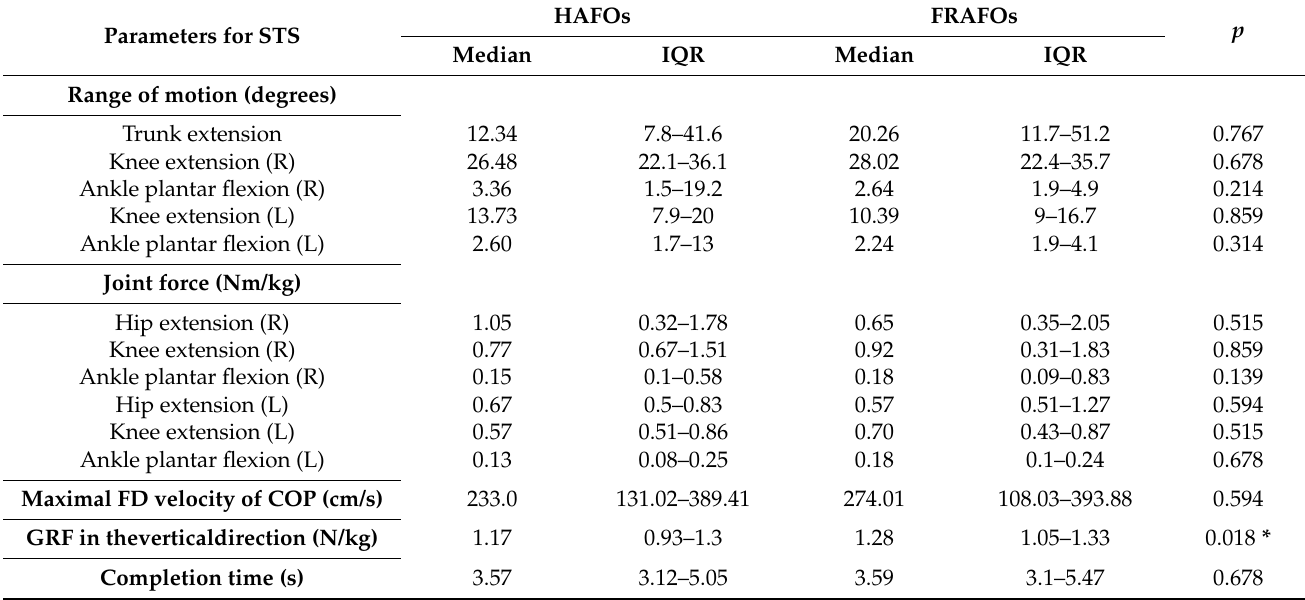
Table 3. Comparison of ROM, joint force, maximal FD velocity of COP, GRF in the vertical direction, and completion time for sit-to-stand performance between participants wearing HAFOs and